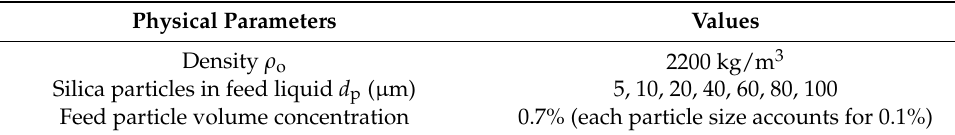
Table 4. Physical parameters of silica